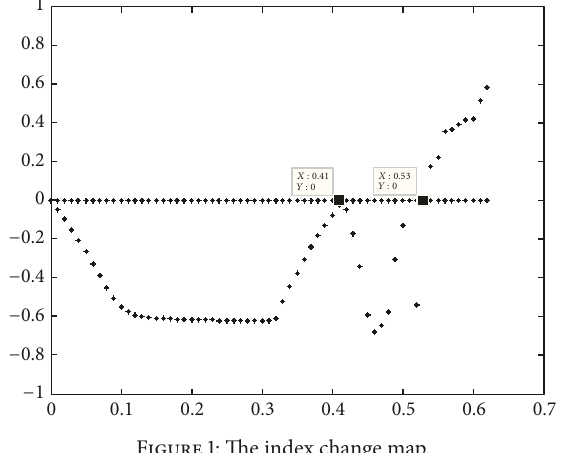
Figure 2: The impact of price adjustment speed of evolution of retailer’s equilibrium